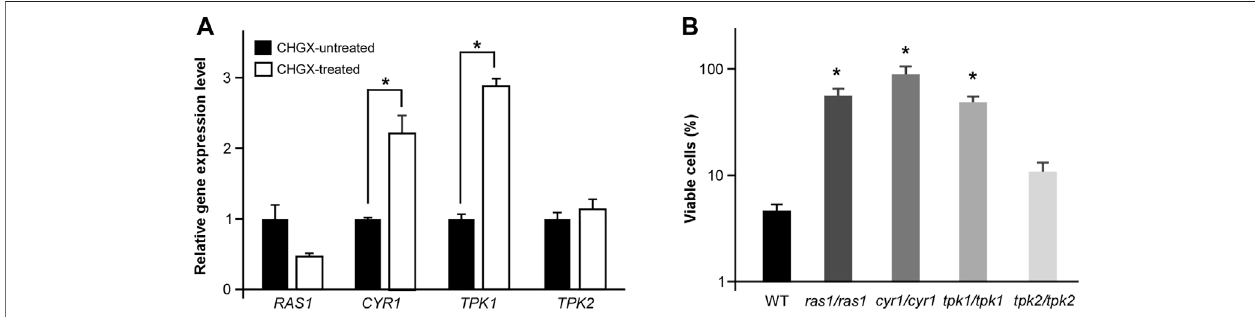
FIGURE 7 | The cAMP-PKA signaling pathway regulates CHGX water-extract-induced cell death of C. albicnas . (A) Relative expression levels of RAS1 , CRY1 , TPK1, and TPK2 inCHGXwater-extracttreatedanduntreated SC5314 cells.TotalRNAwasextracted fromcellsgrowninLee ’ sglucose medium withorwithout CHGX water-extract (20 mg/ml) at 30 ° C for 3 h and used for qRT-PCR assay. The relative gene expression level in CHGX water-extract-untreated cells was set as “ 1 ” . (B) The cell viability assay. Strains used were the WT (SN152), ras1/ras1 , cyr1/cyr1 , tpk1/tpk1 , tpk2/tpk2 mutants. Fungal cells (2 × 10 5 cells/ml) were treated with 20 mg/ml CHGX water-extract in Lee ’ s glucose medium for 3 h at 30 ° C. The percentage of viable cells was determined using plating assays. Three biological repeats wereperformed,andthevaluesarepresentedasmean±SD.One-wayanalysisofvariance(ANOVA)wasusedtocomparedifferencesbetweenWTandmutantstrains; *, p <